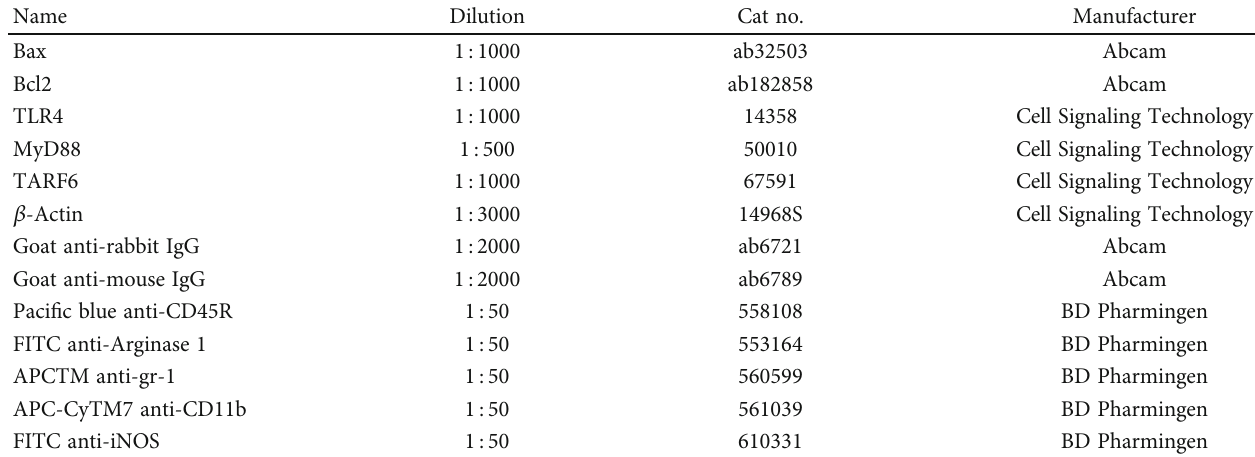
Table 1: Information of